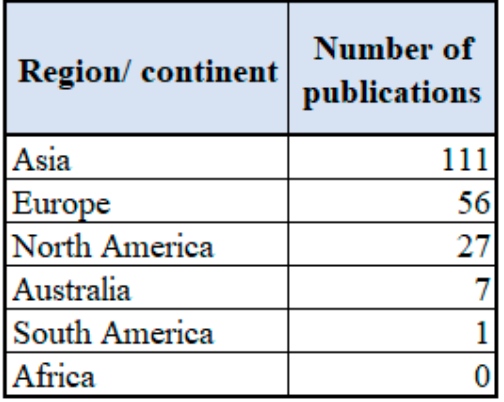
Figure 3. Number of publications per region/continent. The highest number of publications on the topic has been published in Asia.